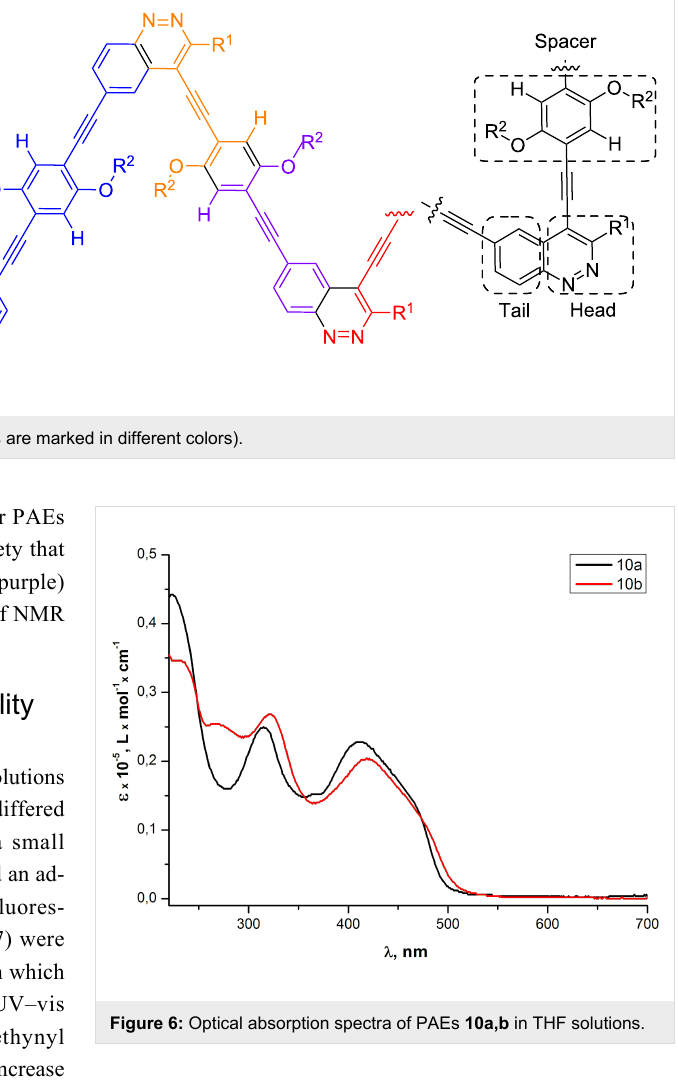
Figure 6: Optical absorption spectra of PAEs 10a,b in THF solutions.